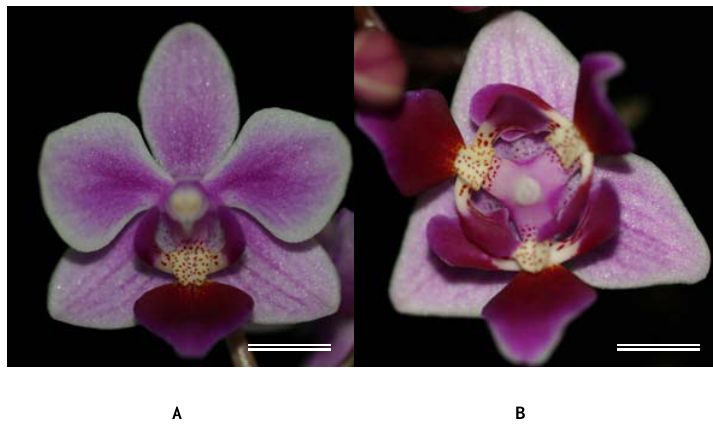
FIGURE 2. Flowers from wild-type (A) and peloric mutant (B) of Phalaenopsis equestris . Bar = 1 cm.